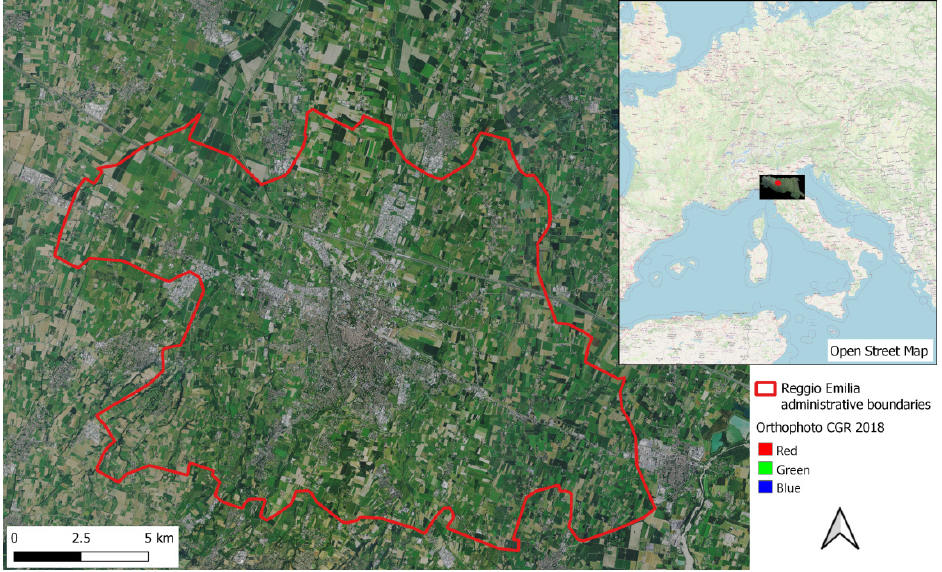
Figure 1. Study area: municipality of Reggio Emilia.